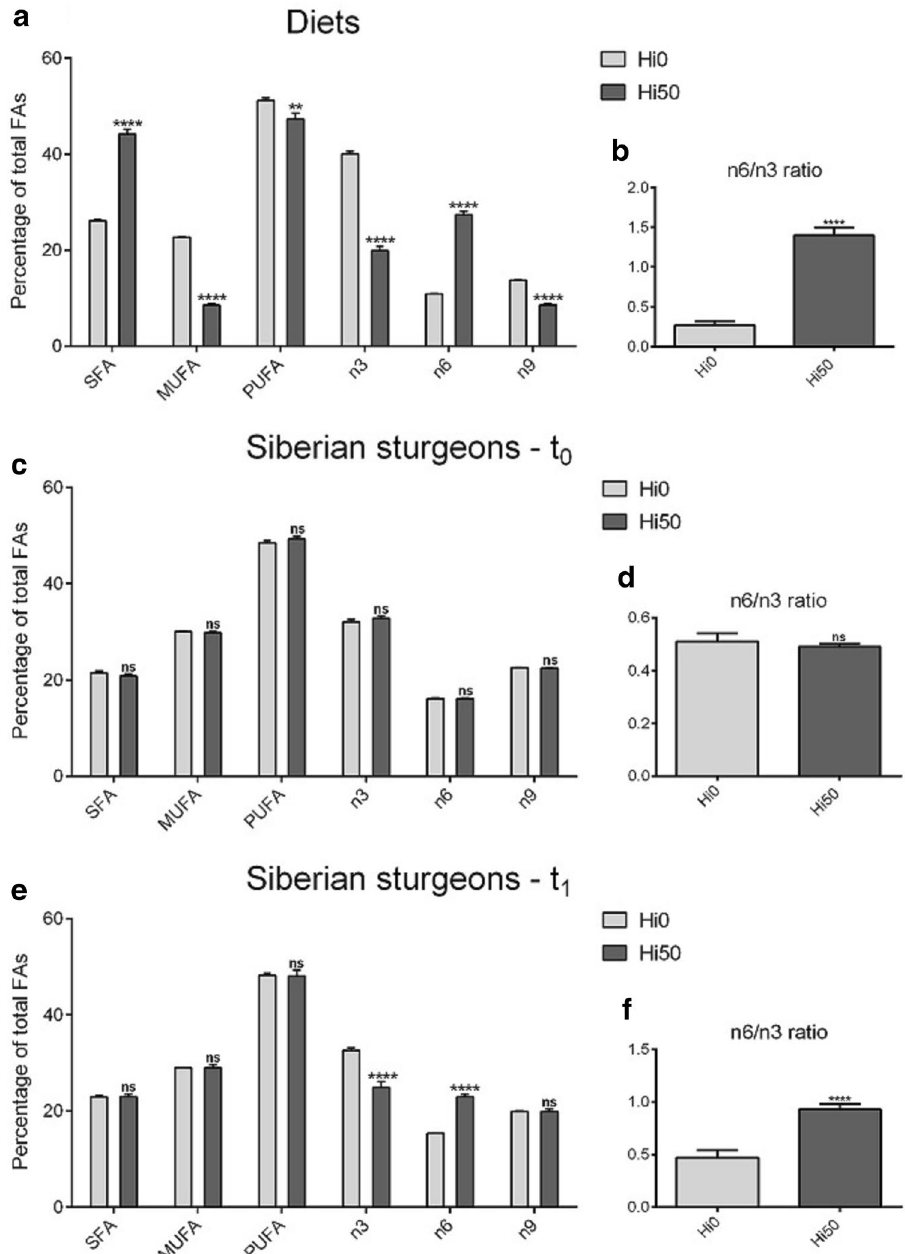
Figure 2. Percentage of SFA, MUFA and PUFA (as % of total FA) and omega 3 (n3), omega 6 (n6) and omega 9 (n9) FA contribution (%) to lipid profile . ( a , b ) Experimental diets including 0 and 50% of BSF meal respect to FM (Hi0 and Hi50); ( c , d ) Siberian sturgeon fillets at t 0 ; ( e , f ) Fillets of Siberian sturgeon fed on the different diets at t 1 . Significant differences between Hi0 and Hi50, compared within the same FA class, are indicated as follows: ns non-significant; *p < 0.05; **p < 0.01; ***p < 0.001 and ****p < 0.0001. Values are shown as mean ± SD (n = 3 for experimental diets; n = 9 for sturgeon at both t 0 and t 1